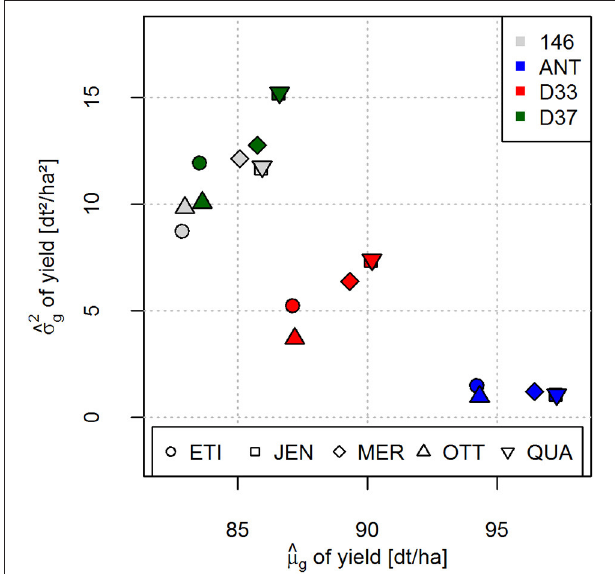
FIGURE 4 | Predicted genetic variances ˆ σ 2 g plotted against the predicted cross means ˆ µ g for yield for the 20 crosses of four donor and five registered elite varieties. Crosses with the different donor lines are distinguished by different colors (right corner legend). Crosses with different elite varieties are distinguished by different symbols (bottom legend). Specific crosses can be identified by the combination of color and